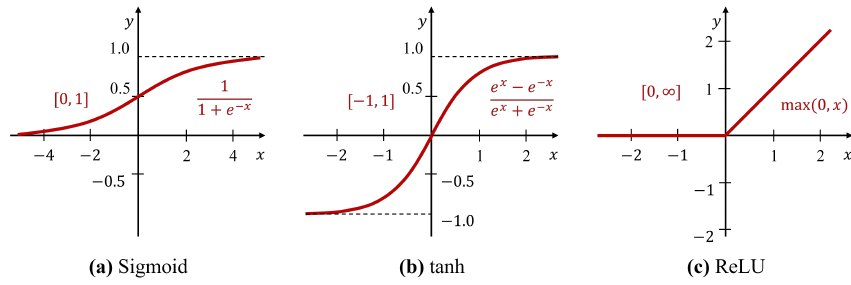
Figure 1. ( a ) Linear model and ( b ) nonlinear model.